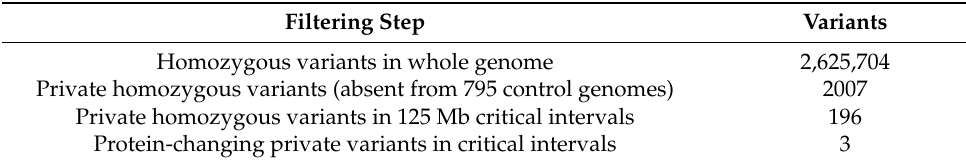
Table 1. Variants detected by whole genome re-sequencing of an affected dog.